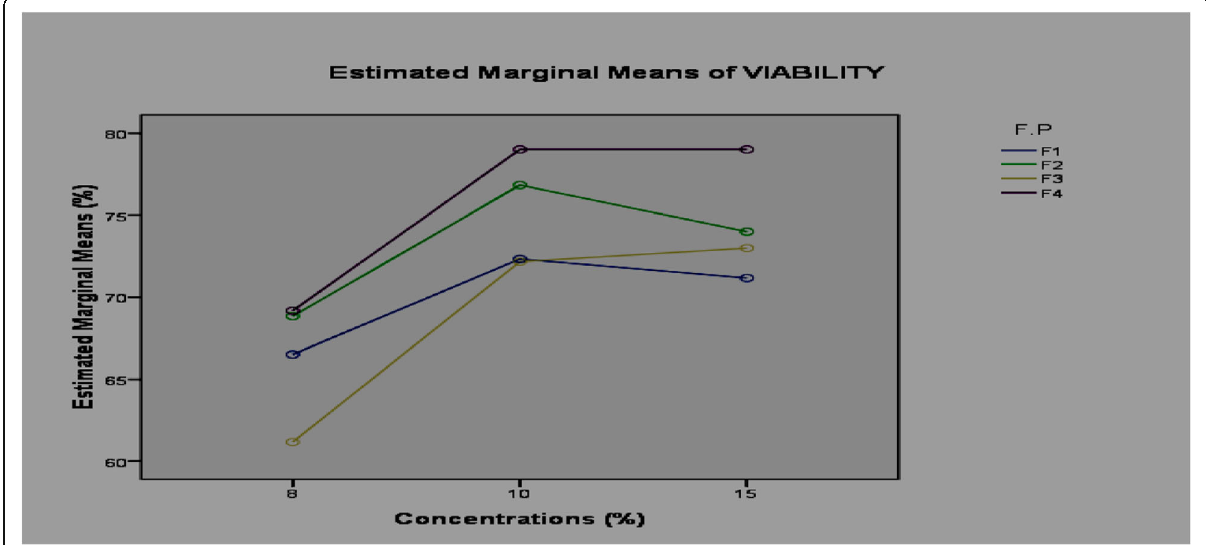
Fig. 3 Effect of different freezing protocols on viability of post-thawed rooster semen on varying concentrations of cryoprotectants